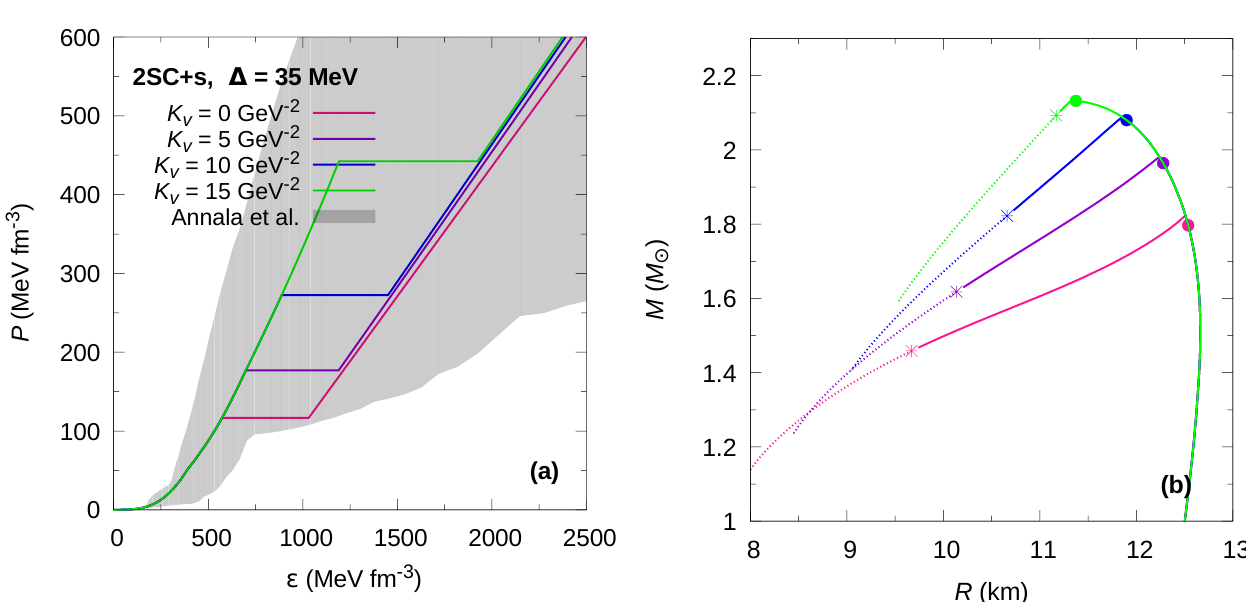
Figure 1. (Color online) Hybrid EoS (panel ( a )) and mass-radius relationship (panel ( b )) for the 2SC+s phase at fixed gap value of ∆ = 35 MeV, for different values of the K v parameter. In panel ( a ), the grey region shows the constraints presented in [42]. The solid dots in panel ( b ) indicate the appearance of the color superconducting phase, just before the maximum mass peak. For rapid conversions, the stellar configurations to the left of each maximum mass are unstable and the existence of HSs is only marginal. For slow conversions, an extended stability branch exists. The stable configurations are shown by continuous lines. The terminal configurations are marked with asterisks.